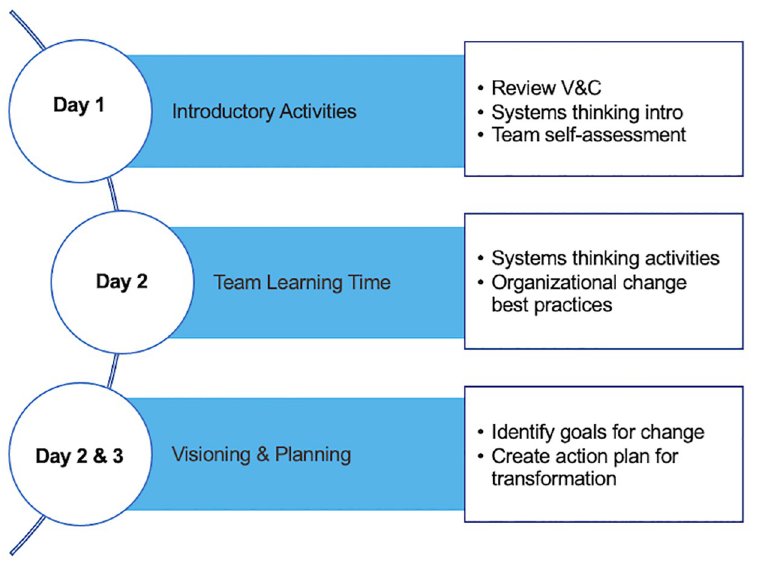
Fig 2. Overview of activities during the three-day NW PULSE